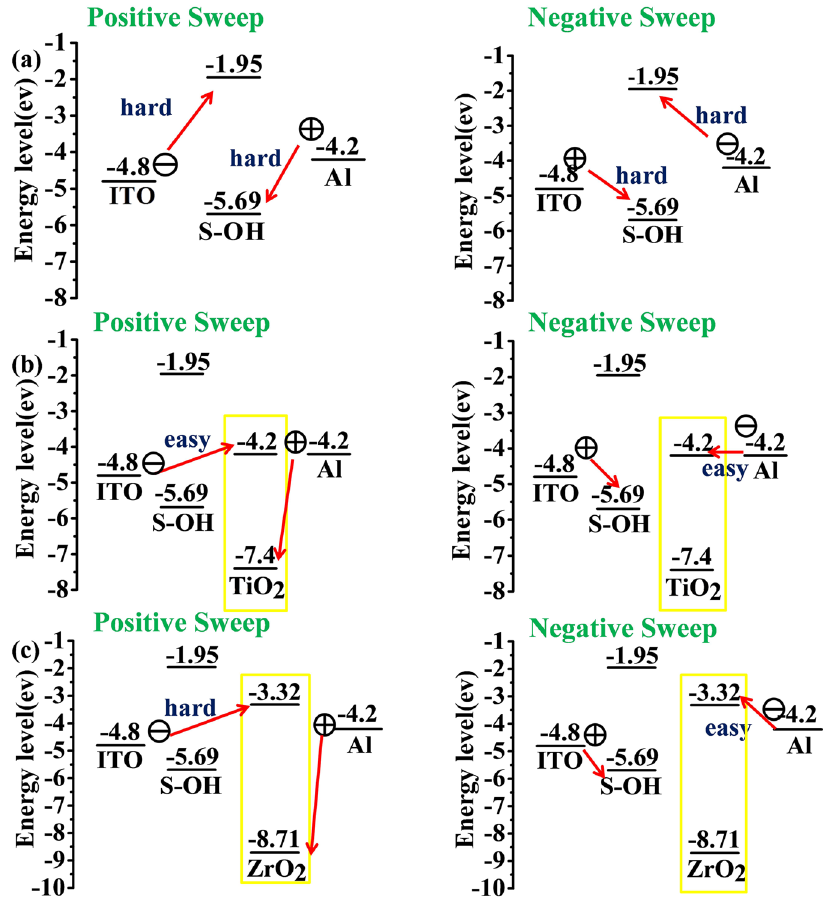
Figure 4. HOMO and LUMO energy levels along with the work function of the electrodes. ( a ) S-OH. ( b ) S-OH and TiO 2 . ( c ) S-OH and ZrO 2